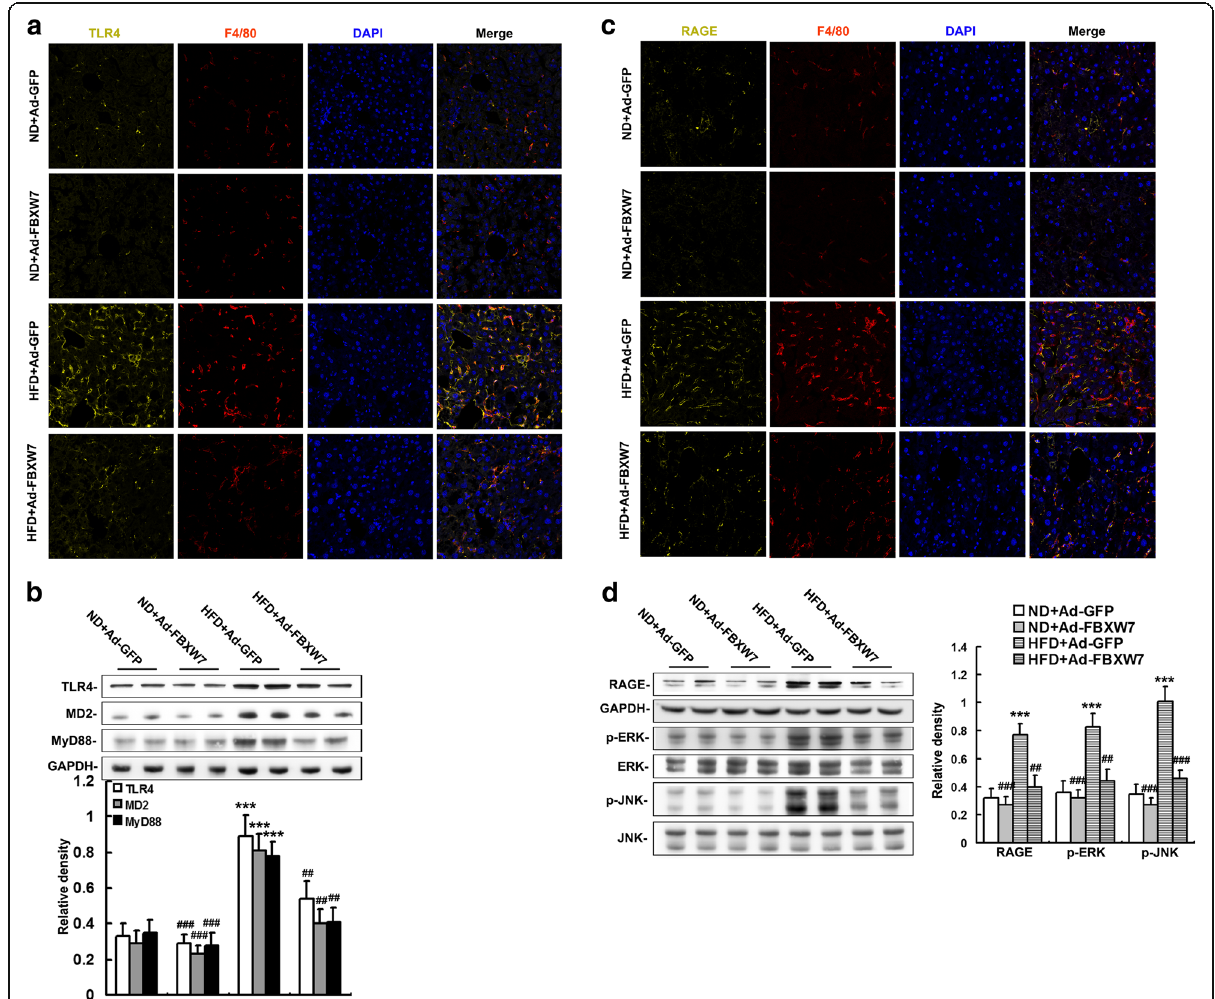
Fig. 6 FBXW7 restrains TLR4 and RAGE signaling in HFD-fed mouse livers ( n = 4). a Representative confocal immunofluorescence images of TLR4 (yellow), F4/80 (red) and DAPI (blue) in mouse livers. b Immunoblotting and densitometry of the components of TLR4 signaling in mouse livers. c Representative confocal immunofluorescence images of RAGE (yellow), F4/80 (red) and DAPI (blue) in mouse livers. d Immunoblotting and densitometry of the components of RAGE signaling in mouse livers. *** P < 0.001 versus the ND + Ad-GFP group; ## P < 0.01, ### P < 0.001 versus the HFD + Ad-GFP